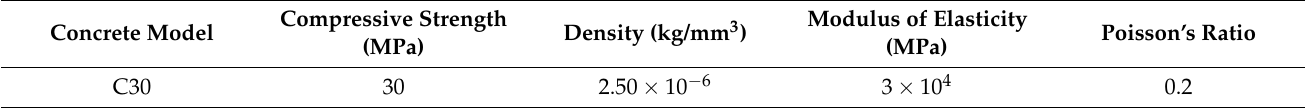
Table 7. Concrete material parameters.